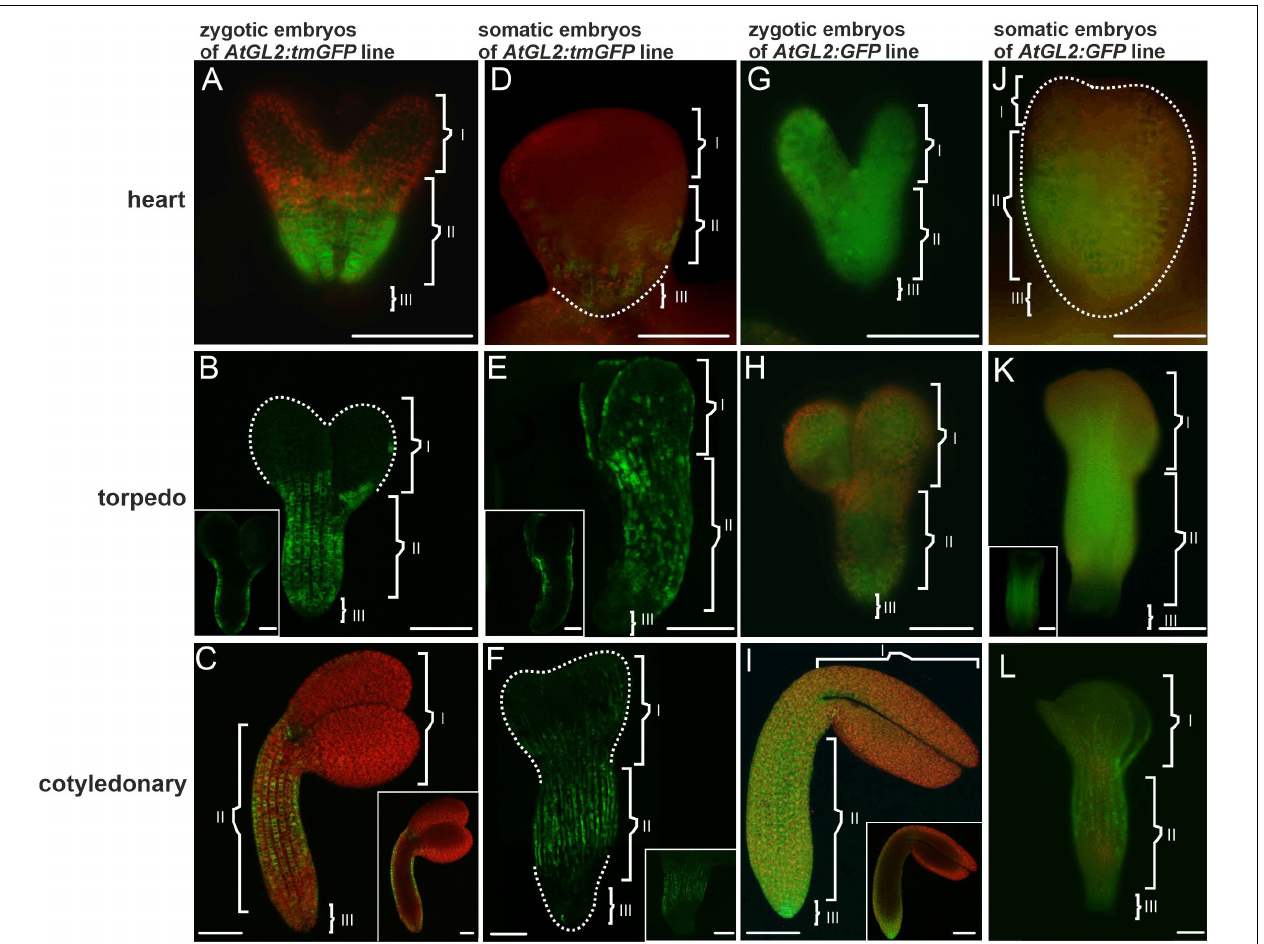
FIGURE 3 | The AtGL2 promoter activity and GFP distribution pattern in the ZEs and SEs. (A) AtGL2 promoter activity in the ZE in the heart stage, (B) in the torpedo and (C) cotyledonary stages. (B,C insets) An optical section. (D) Heart stage of the SE – fluorescence in the central and basal part of the embryo. (E) The torpedo stage – promoter activity is present in the protodermal cell of the entire embryo. (E inset) An optical section showing the fluorescence in the protodermal cells. (F) Cotyledonary stage with fluorescence in the protodermal cells of the hypocotyl and cotyledons. The GFP distribution in the (G) heart, (H) torpedo, and (I) cotyledonary stages of the ZE embryos. (I inset) An optical section. The GFP in the (J) heart and (K) torpedo stages of the SE. (K inset) Hand-cut section through the SE – fluorescence in the provascular tissue. (L) Cotyledonary stage of the SE. Dotted lines indicate the embryo surface. ( I, II, and III – description is the same as for Figure 1 ). A,D,G,H,J,K,K inset – images from the epifluorescence microscope; B,C,C inset,E,E inset,F,I,I inset,L,L inset – images from the CLSM. Scale bars = 100 µ